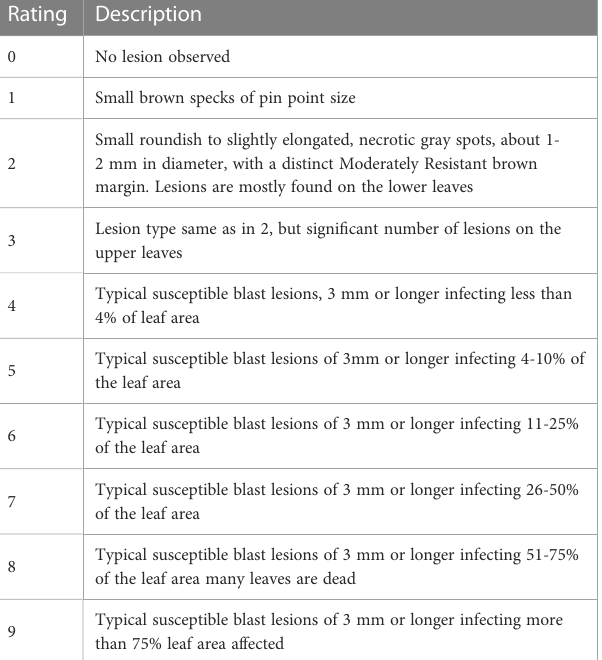
TABLE 2 Description of different scores of rice blast